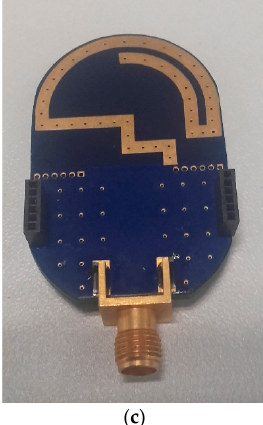
Figure 10. Fabricated wrist-worn wireless SpO2 sensor prototype: ( a ) top view with no top enclosure; ( b ) bottom view; ( c ) antenna PCB bottom view.